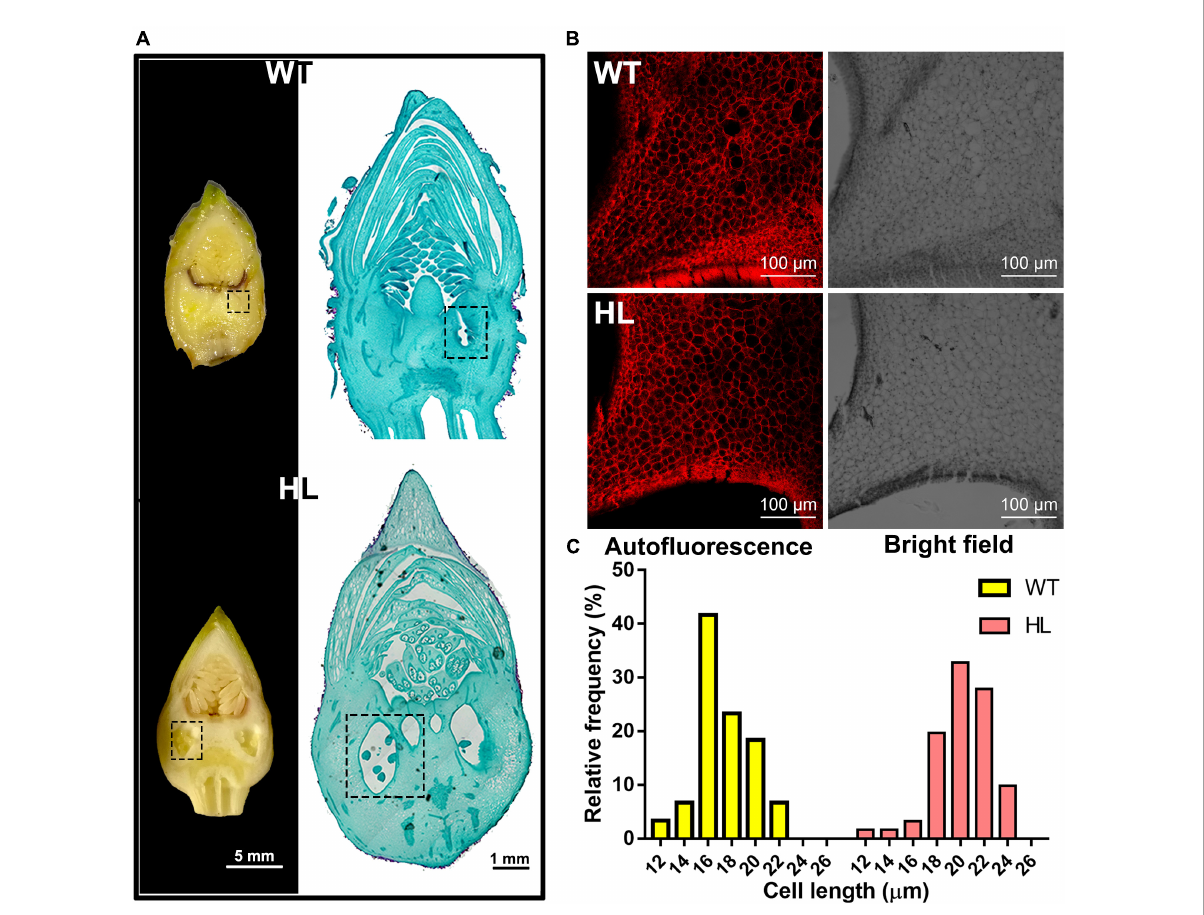
FIGURE3 Histological analysis of the ovary of WT and HL fruits. (A) Longitudinal sections (left, Scale bar = 5 mm) and representative paraffin sections of the reproductive organizations of 12-week-old WT and HL (right, Scale bar = 1 mm). The ovary, denoted with the dotted box, was larger in HL fruits when compared with WT at the same developmental stage. (B) Cells around the ovary of WT and HL were observed using a fluorescent microscope. Images including bright field and red autofluorescence are shown. Scale bar = 100 µ m. (C) Cell length of WT and HL were evaluated using six 12-week-old fruits per line. Statistical count was shown as the frequency distribution of the cell length. HL, hybrid Euryale lines; WT, wild type (North Gordon